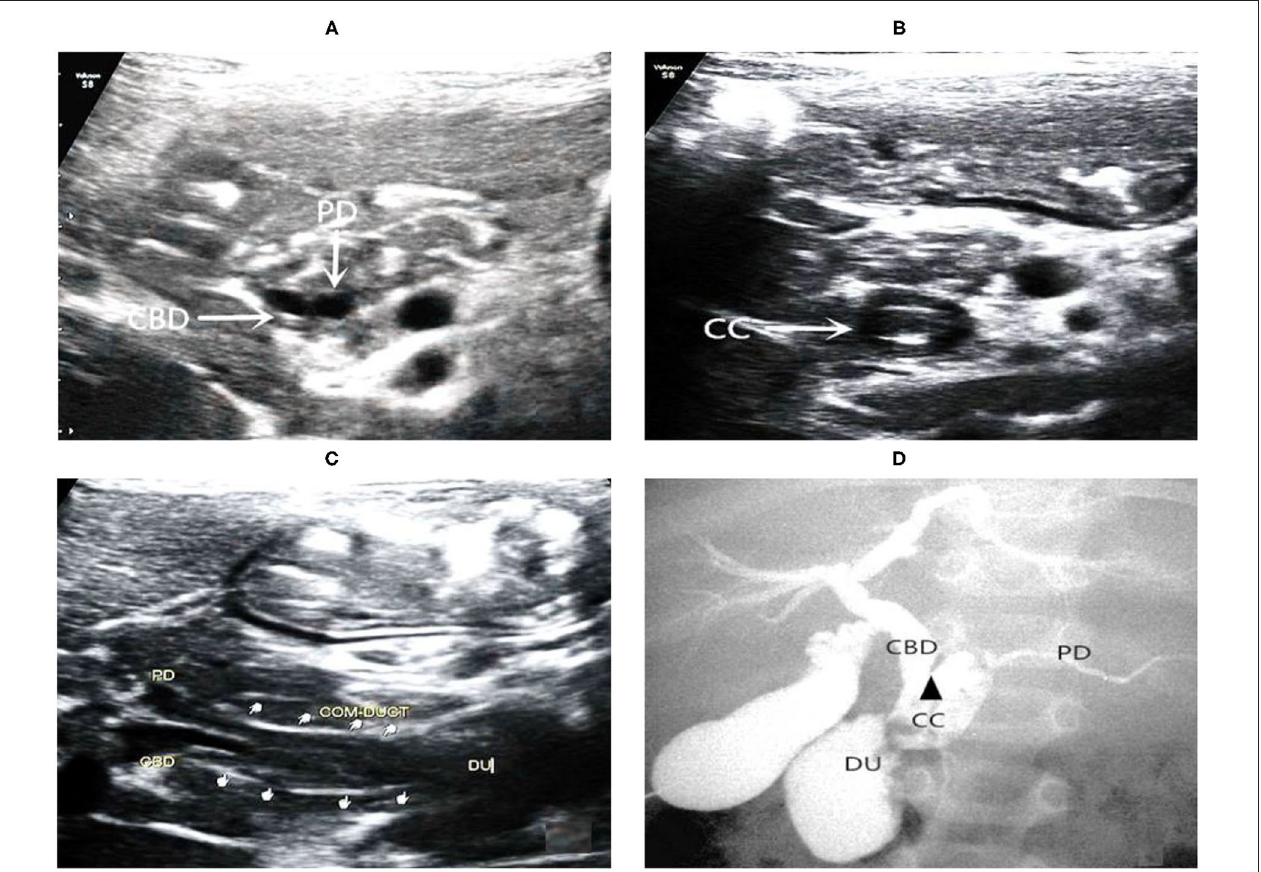
FIGURE 3 | Images of a representative type C of PBM. (A) US transverse scan showed the axial section of both the terminal of the CBD and the PD; (B) US transverse scan showed the axial section of common channel and indicated protein plugs within; (C) US oblique scan showed the terminal CBD and the PD parallel each other and join at the end into the common channel which drains into the duodenum; (D) IOC confirmed dilations of the common channel and the CBD. There is an acute angle (arrow head) of interjunction of the PD and